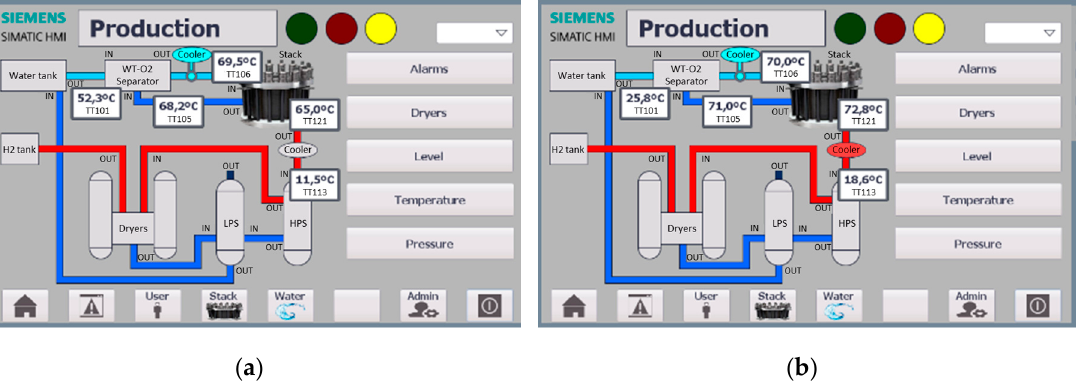
Figure 15. Cooling subsystem monitoring interface: ( a ) warning by high water temperature; ( b ) warning by high hydrogen temperature.